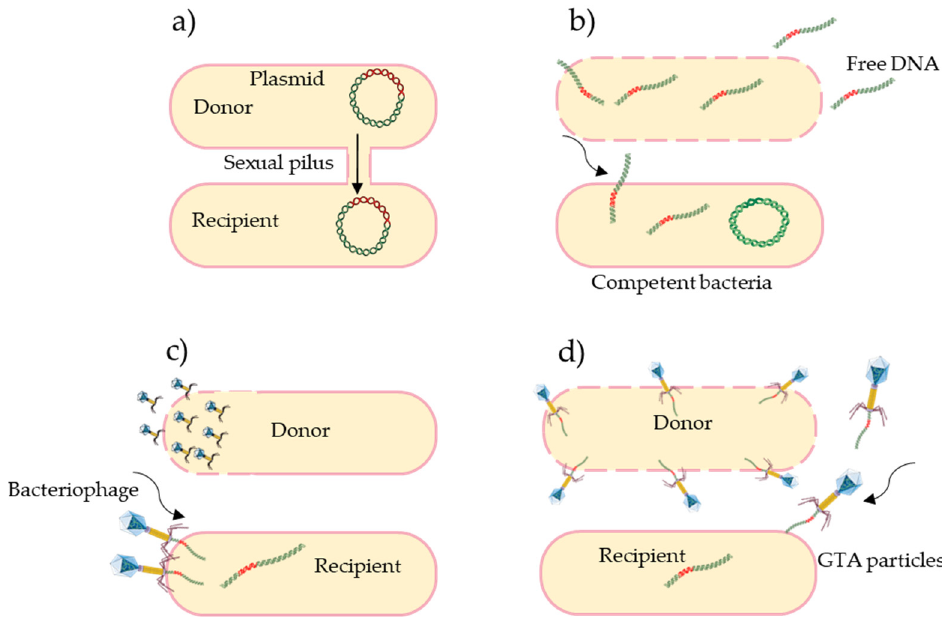
Figure 1. Antibiotic resistance transport mechanisms; ( a ) Conjugation, ( b ) Transformation, ( c ) Transduction, and ( d ) Gene transfer agents (GTAs), (adapted from [34]).